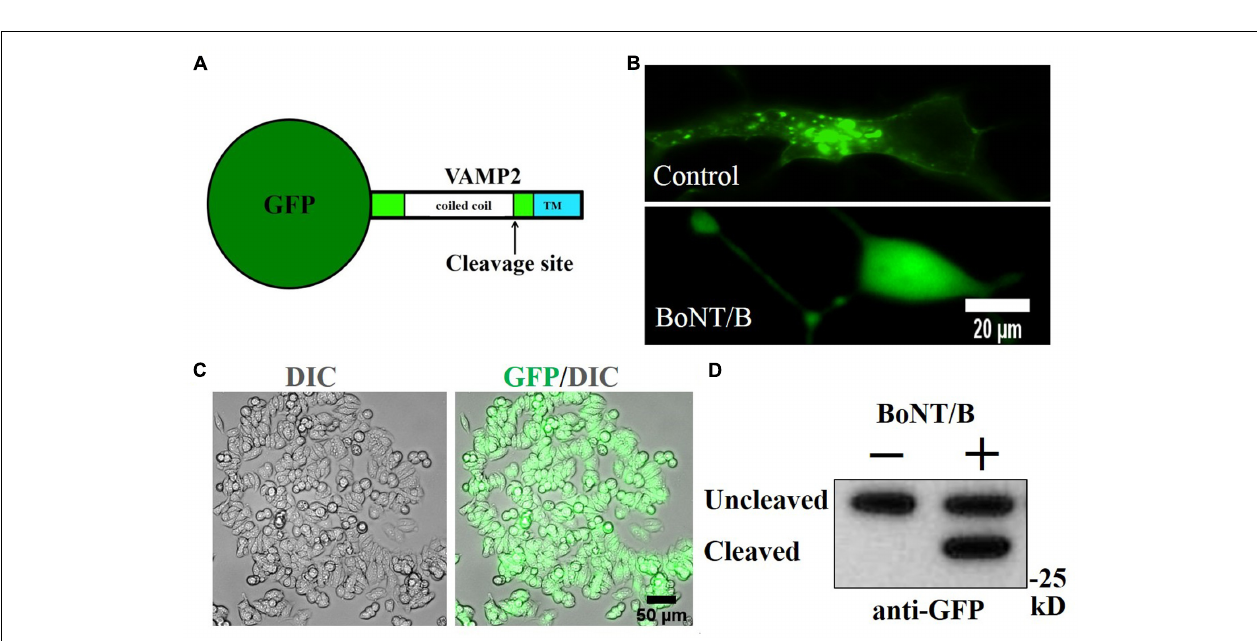
FIGURE 2 | Generation of GFP-VAMP2 SiMa cell line using viral transduction. (A) Schematic showing the fusion protein containing GFP inserted at the amino terminus of VAMP2. TMR, transmembrane region. (B) GFP-VAMP2 localizes to vesicular structures (top) and is released into the cytosol (bottom) upon incubation with BoNT/B (30 nM). (C) Robust expression following viral transduction and puromycin selection is evident in GFP and differential interference contrast (DIC) merged images. (D) Stable GFP-VAMP2 cleavage product can be detected following incubation with BoNT/B (30 nM). Immunoblotting was performed using a GFP antibody.